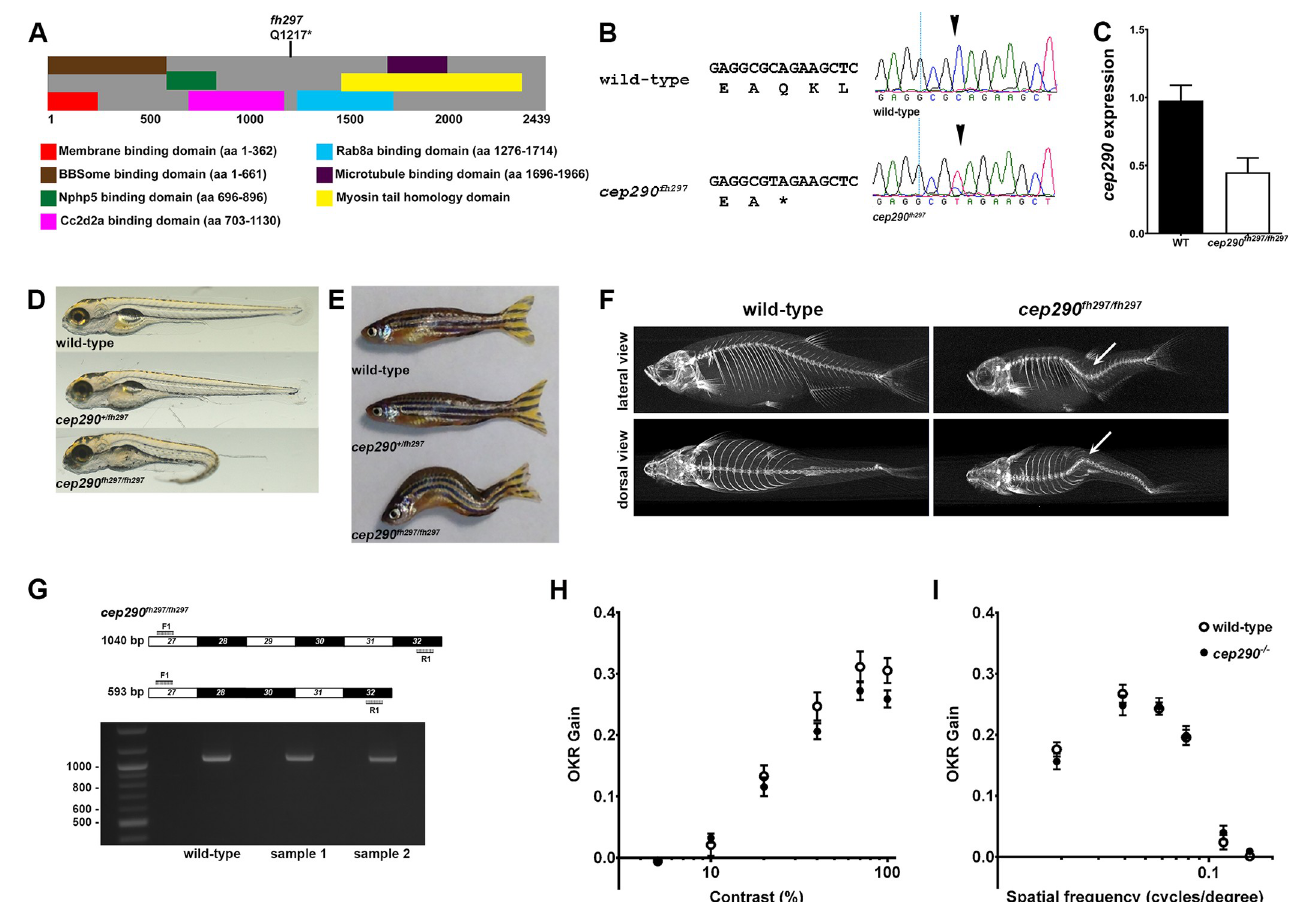
Fig 1. Genetic mapping and identification of cep290 mutant allele. (A) Schematic structure of zebrafish Cep290 illustrating the location of predicted protein domains. Domain structure is based on prior results [12, 44, 45]. The cep290 fh297 allele generates a premature stop codon at amino acid 1217. (B) Chromatograms of Sanger sequencing reactions of cDNAs from wild-type and homozygous cep290 fh297/fh297 mutant confirming the C > T replacement. (C) Quantification of cep290 mRNA in 6 month old wild-type and mutant retinas by digital droplet PCR (ddPCR). (D) Lateral views of representative wild-type (top), heterozygous (middle), and homozygous (bottom) mutants at 5 dpf. At larval stage 30% of cep290 fh297/fh297 mutant animals show ventral tail curvature. (E) Lateral view of 7 month old wild-type, heterozygous and a representative cep290 fh297/fh297 mutants displaying distorted vertebral column. At adult stage 100% of the homozygous mutant animals show scoliosis of the vertebral column. (F) Representative micro-CT-generated images of lateral (top) and dorsal (bottom) views of adult wild-type and cep290 fh297/fh297 mutants. Images demonstrate that spinal curvature deviates within the dorsal/ventral plane as well as curves laterally (arrows). (G, top) Forward (F1) and reverse (R1) PCR primers were designed to bind sequences in exons 27 and 32 in order to flank exon 29 harboring the mutant cep290 fh297 allele. Exon skipping would result in a truncated PCR product of 593 bp, while retention of exon 29 would result in a full- length 1040 bp product. (G, bottom) Results of PCR reactions from cDNAs generated from wild-type and samples of two individual mutants resulted in full- length products of 1040 bp. 100 bp ladder shown in lane 1. (H) Optokinetic response (OKR) contrast response function of 5 dpf wild-type larvae (n = 11; open circles) and cep290 fh297/fh297 mutants (n = 26; closed circles). No significant differences were found. (I) OKR spatial frequency results for wild-type larvae (n = 13) and cep290 fh297/fh297 mutants (n = 15). Error bars = s.e.m.